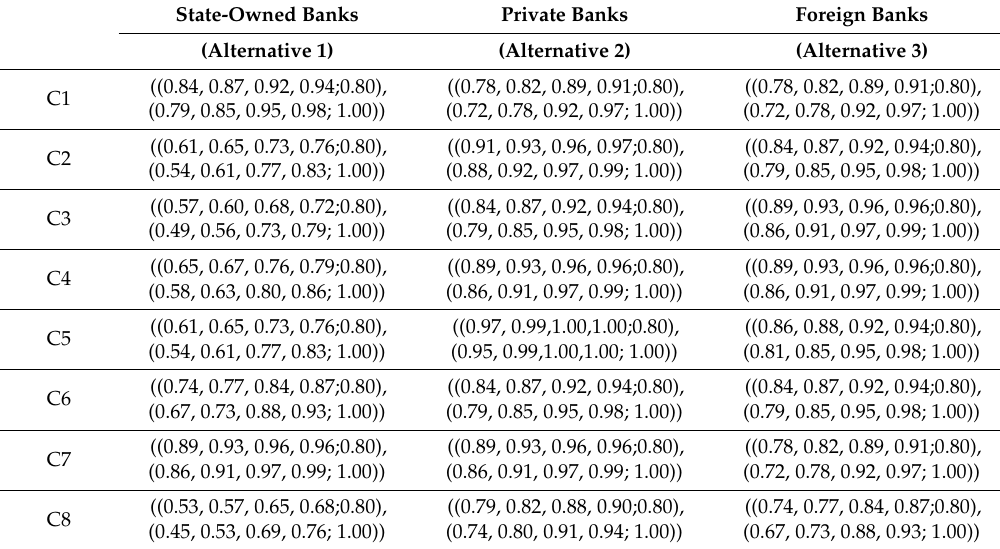
Table 7. Decision Matrix.